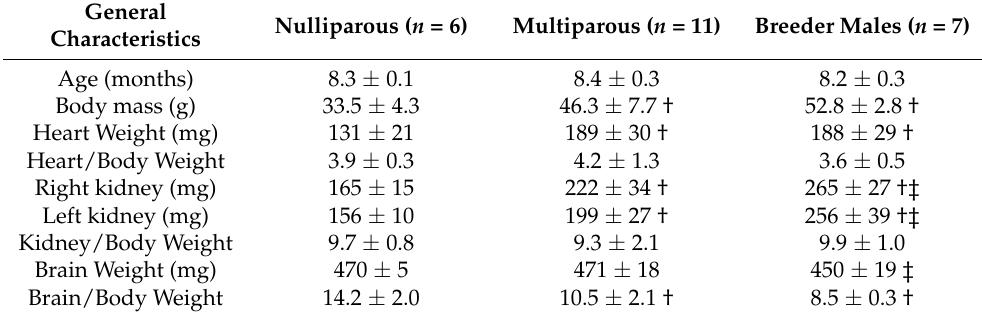
Table 1. General characteristics of